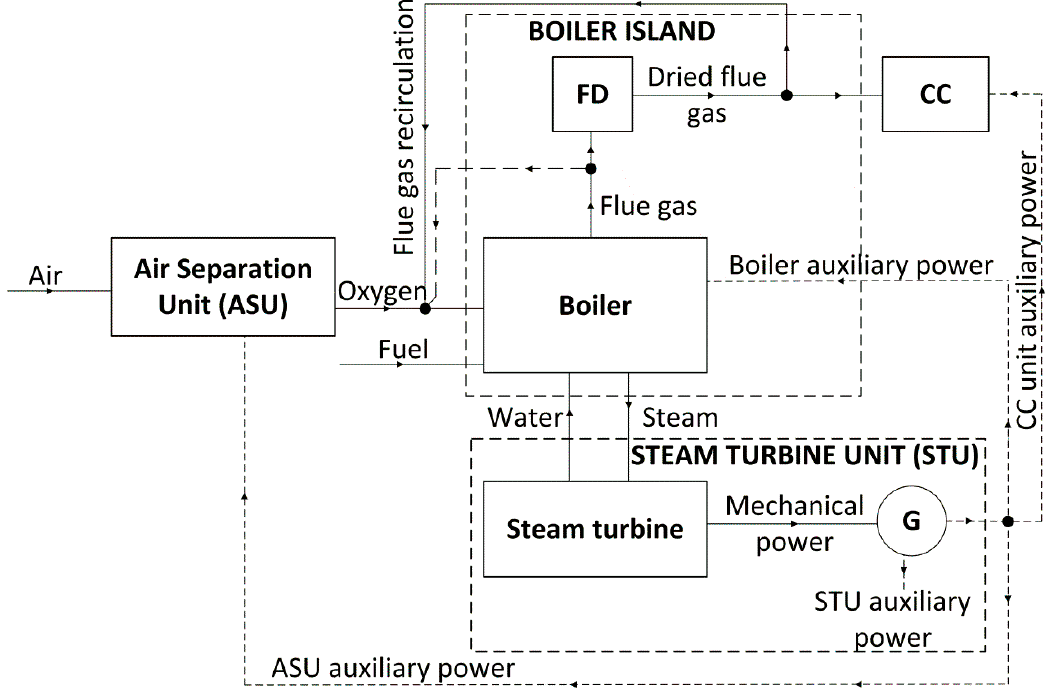
Figure 1. Overall scheme of an oxy-type power plant (CC–carbon dioxide capture and compression unit; FD–flue gas cleaning–drying system; G–electric generator).